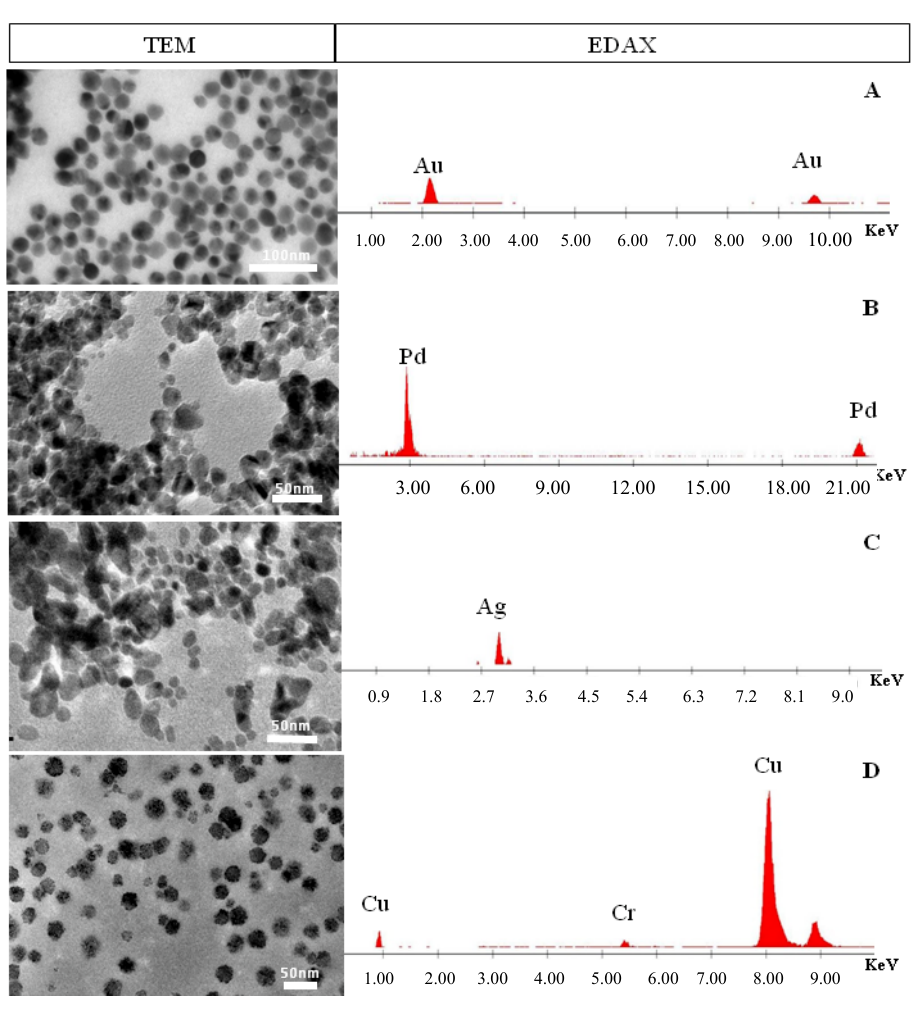
Figure 9. Left column: Representative TEM images of nanoparticles composed of different metals that were formed by heating a solution of the metal ion precursor with the plasmid DNA in Tris buffer at 70 ° C for various times. The Au reaction was heated for 12 h, the Pd reaction was heated for 17 h, the Ag reaction was heated for 10 h, and the Cr reaction was heated for 10 h. From the top are the TEM of the Au, Pd, Ag, and Cr nanoparticles. Right column: EDAX Netcounts (sample area minus control area) spectra indicate the composition of the metallic nanoparticles found in the TEM images. From the top are the EDAX spectra of ( A ) Au, ( B ) Pd, ( C ) Ag. For the Cr nanoparticles ( D ), the Netcounts method was not used so the x-ray scattered lines from the carbon coated copper grid, show up in the spectrum (indicated by the Cu